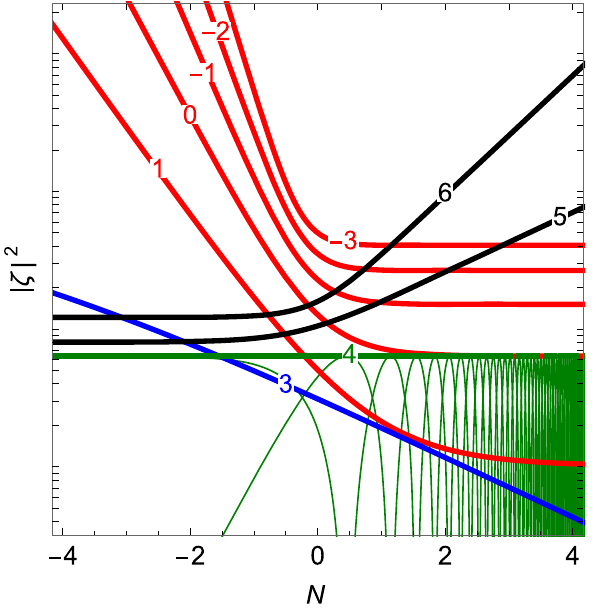
Fig. 1 Evolutions of the amplitude of curvature perturbation ζ given ∝ a p with different values of p in Eq. (8) for different sound speeds ˜ v 2 k is shown as thick lines. Color coding corresponds to late-time behavior: freezing (red), decaying (blue) and growing (black); the special case of p = 4 is shown in green. Thin green lines indicate the real and imaginary part of of ζ for p = 4. Normalization of ζ is arbitrary